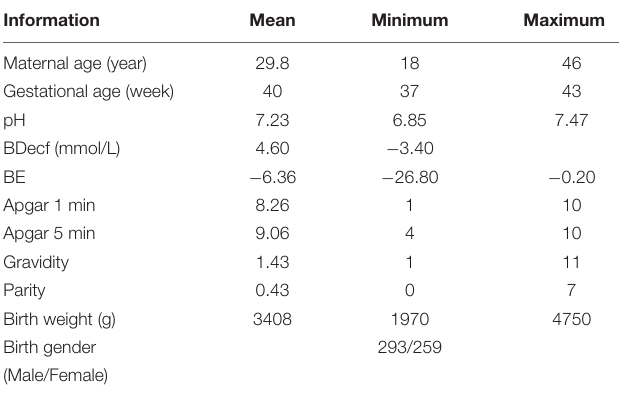
TABLE 1 | Overview of the available information in the open-access intrapartum CTU-UHB cardiotocography (CTG) database.